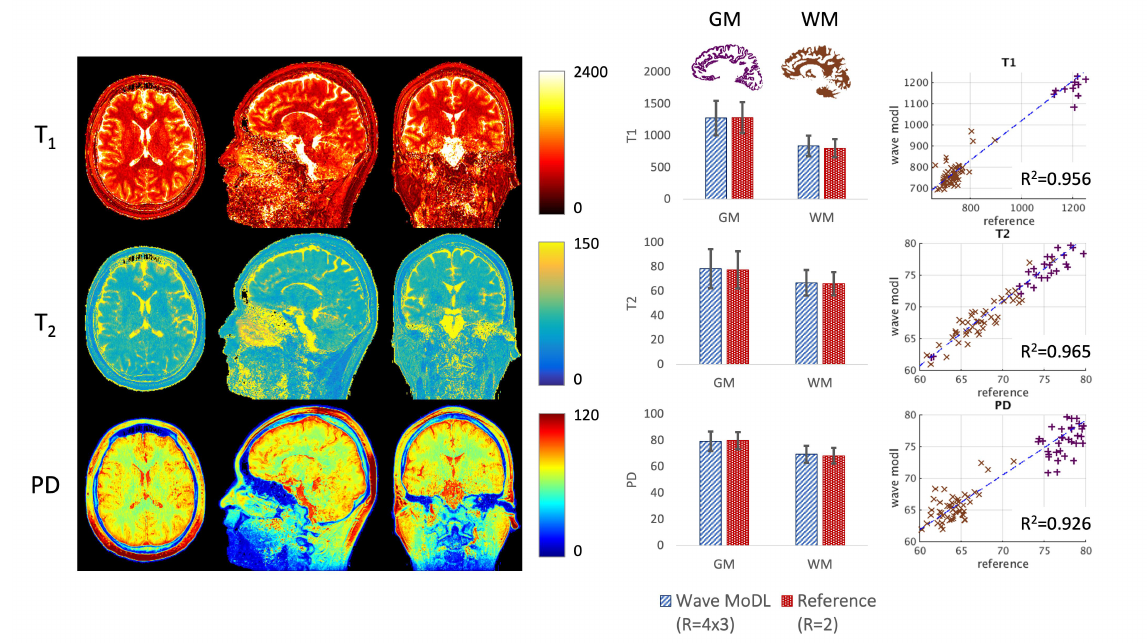
Figure 6. T 1 , T 2 , and PD maps were calculated using the wave-MoDL results. The last column shows the correction between the reference ( R = 2) and the quantitative values of wave-MoDL ( R = 4 × 3) in the randomly selected 5 × 5 × 5 boxes in gray matter (purple) and white matter